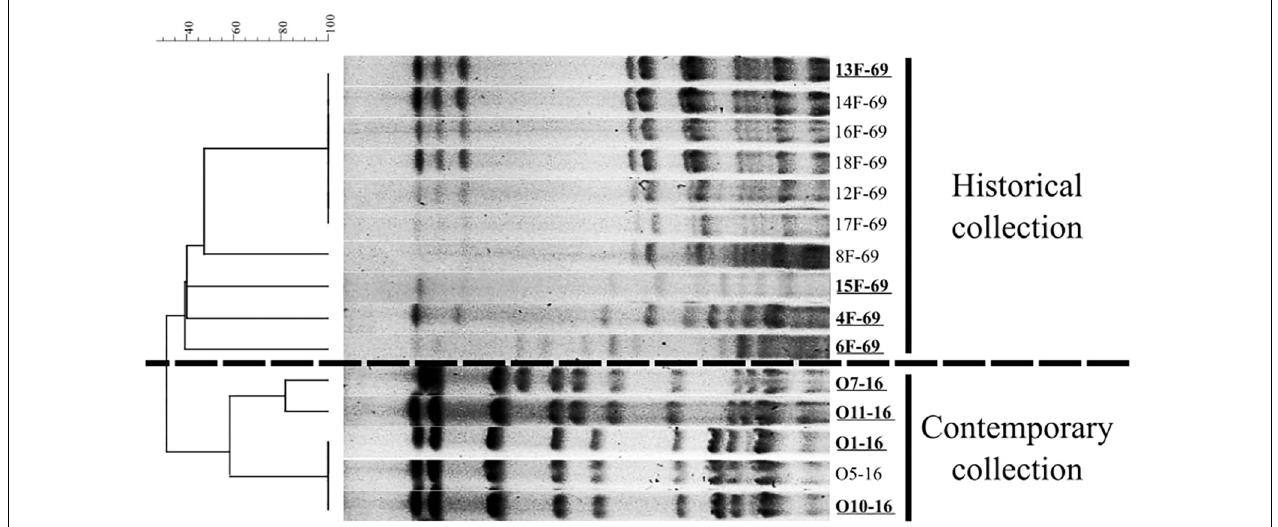
FIGURE 1 | Dendrogram based on Dice’s coefficient showing the representative pulse-field gel electrophoresis (PFGE) pattern of the historical (10 out of 21 isolates) and the contemporary Serratia marcescens collections studied.